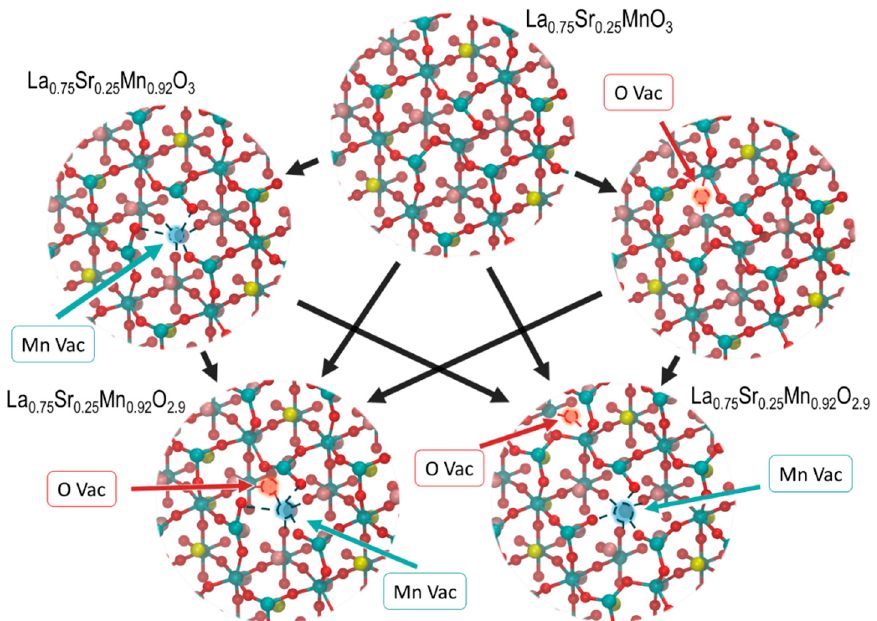
Figure 4. The various vacancy formation pathway and vacancy orderings. Red, blue, pink, and yellow color atoms are O, Mn, La, and Sr, respectively. Visualization was created by VESTA [20]. Table 1. Table of neutral vacancy formation energies. The numbered intersections as shown in Figure 3 correspond to the numbered vacancies as shown in the table below.